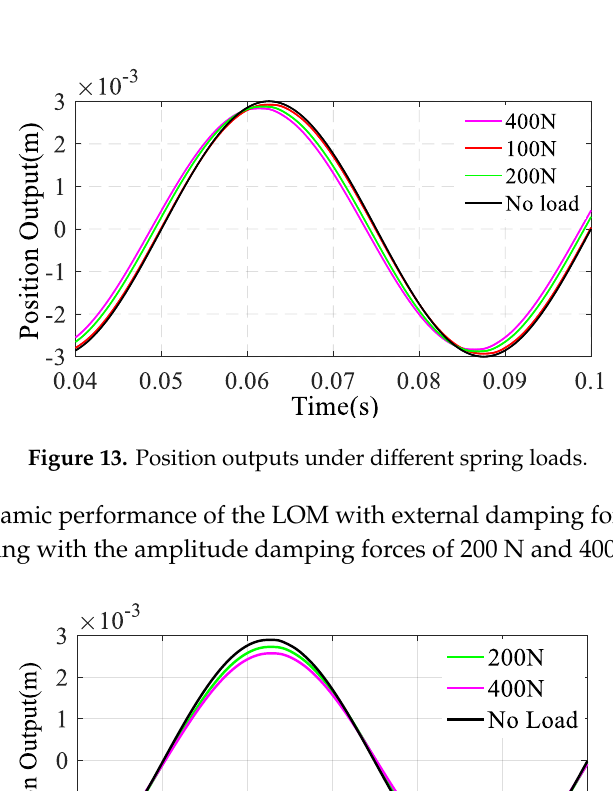
Figure 13. Position outputs under different spring loads.